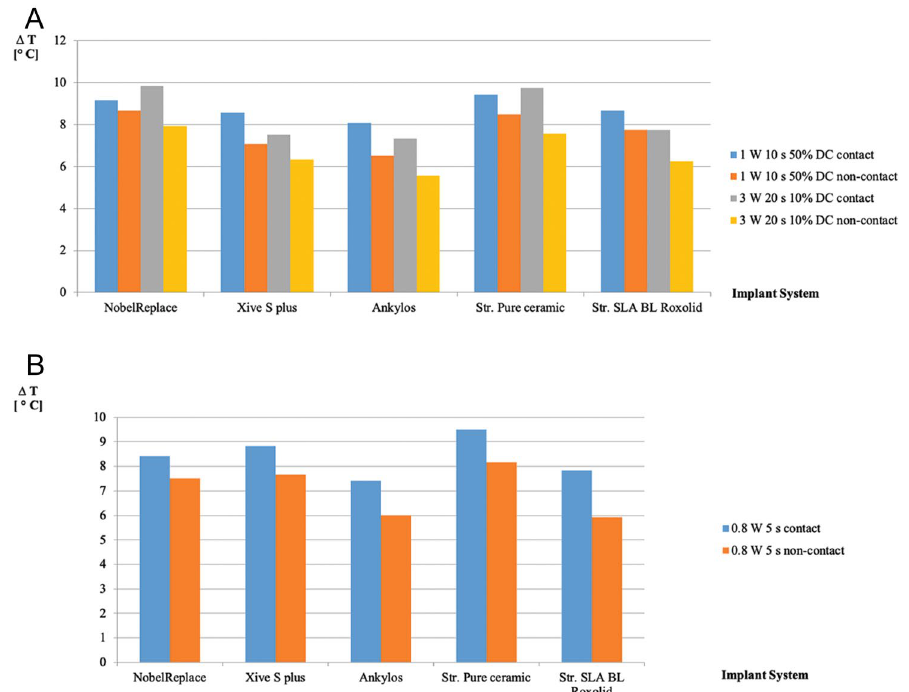
Figure 2. Temperature response curves for the increase in cervical interface temperature (∆T [°C]) as a result of different wattages (0.8 W), exposure times (5 s) and modes in five commercial dental implant systems (NobelReplace, Xive S plus, Ankylos, Straumann Pure ceramic and Straumann SLA Bone Level [BL] Roxolid): ( A ) Wattage 1–3 W, exposure times 10 s and 20 s in pulsed mode. ( B ) Wattage 0.8 W, exposure time 5 s in continuous wave mode.